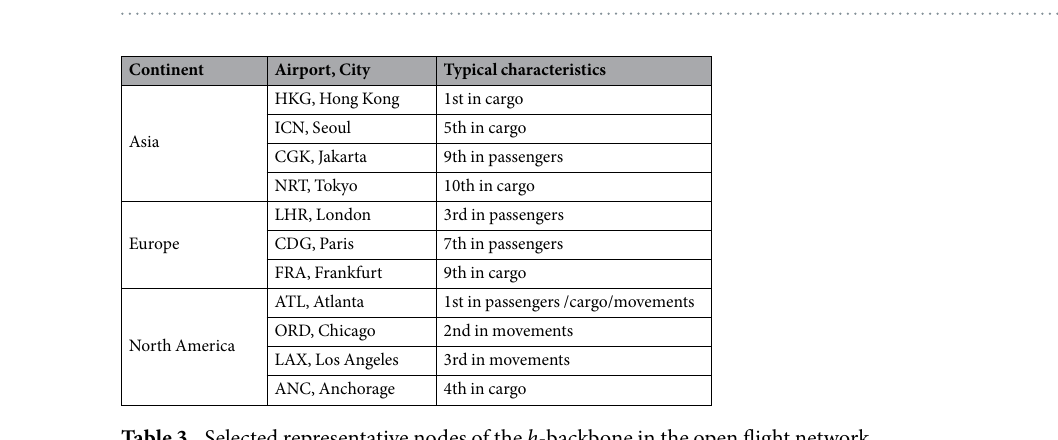
Table 3. Selected representative nodes of the h -backbone in the open flight